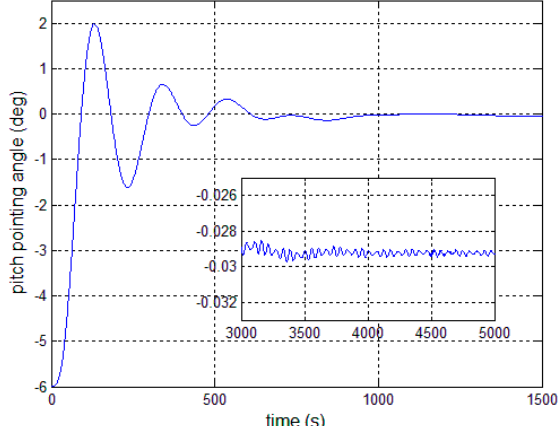
Figure 14. Antenna pitch angle error—controller, Equation (30).